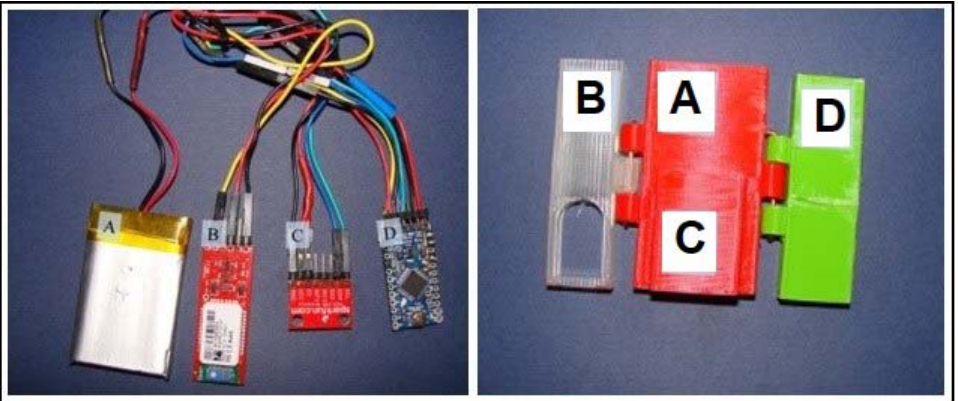
Figure 1. The components of a Lameness Detector 0.1 device ( left panel ): accumulator ( A ), Bluetooth ( B ), accelerometer ( C ), Arduino board ( D ), and their case ( right panel ) with the appropriate boxes for each component, labeled accordingly (( A ) for the accumulator, ( B ) for the Bluetooth, ( C ) for the accelerometer, and ( D ) for the Arduino board, respectively).